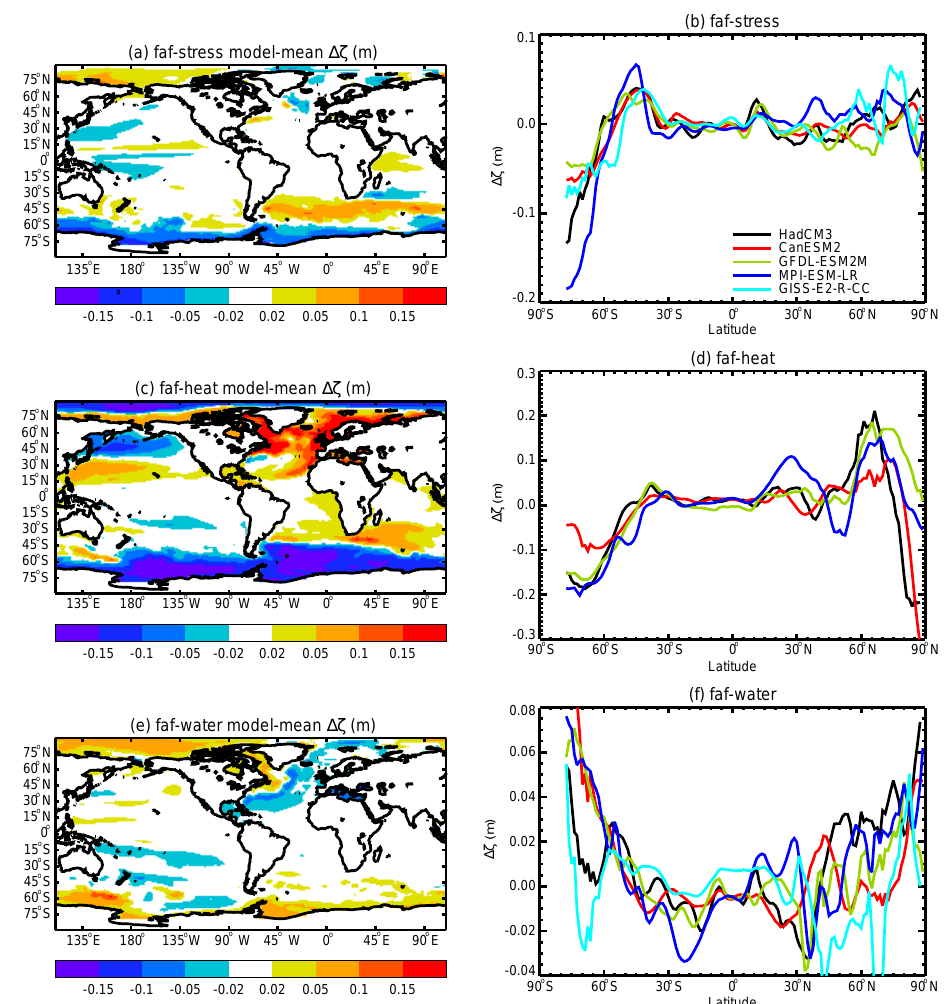
Figure 8. Change in dynamic sea level (cid:49)ζ (m) in the time mean of the final decade of the FAFMIP experiments relative to the control, model mean on the left, zonal means of individual models on the right. Note that the panels on the right have different scales for the (cid:49)ζ